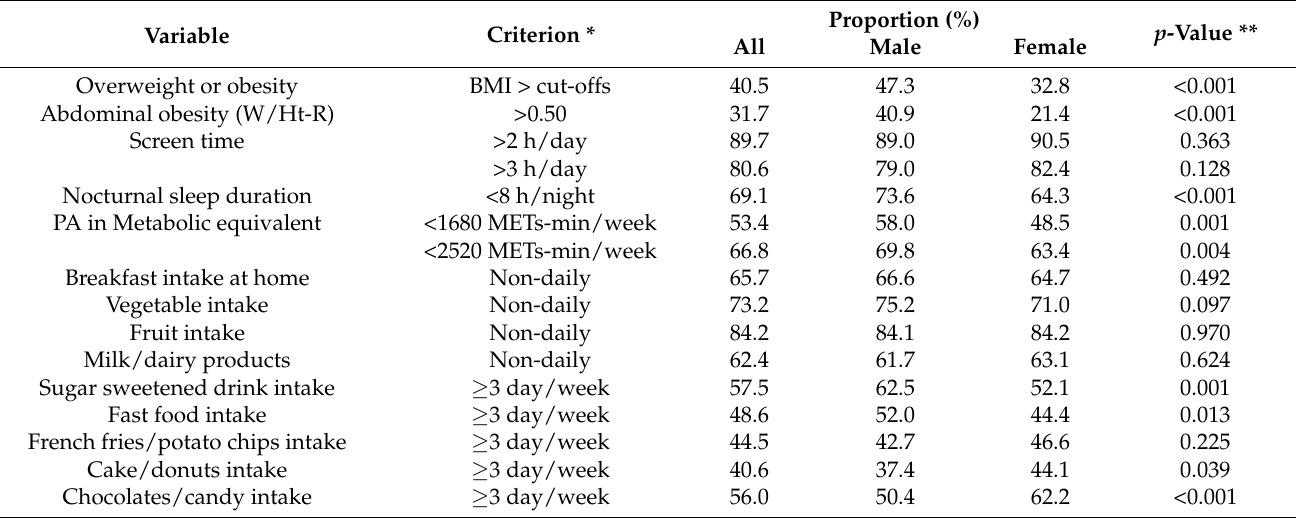
Table 2. The proportions (%) of Saudi adolescents who exceeded certain cut-off values for over- weight/obesity and selected lifestyle behaviors.